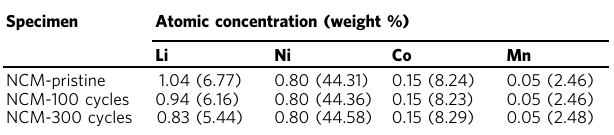
Table 1 Compositions of cationic elements in pristine Li (Ni 0.80 Co 0.15 Mn 0.05 )O 2 (NCM) and NCM subjected to 100 and 300 cycles as measured by ICP-AES (the atomic concentration is normalised to obtain a total TM fraction of 1).